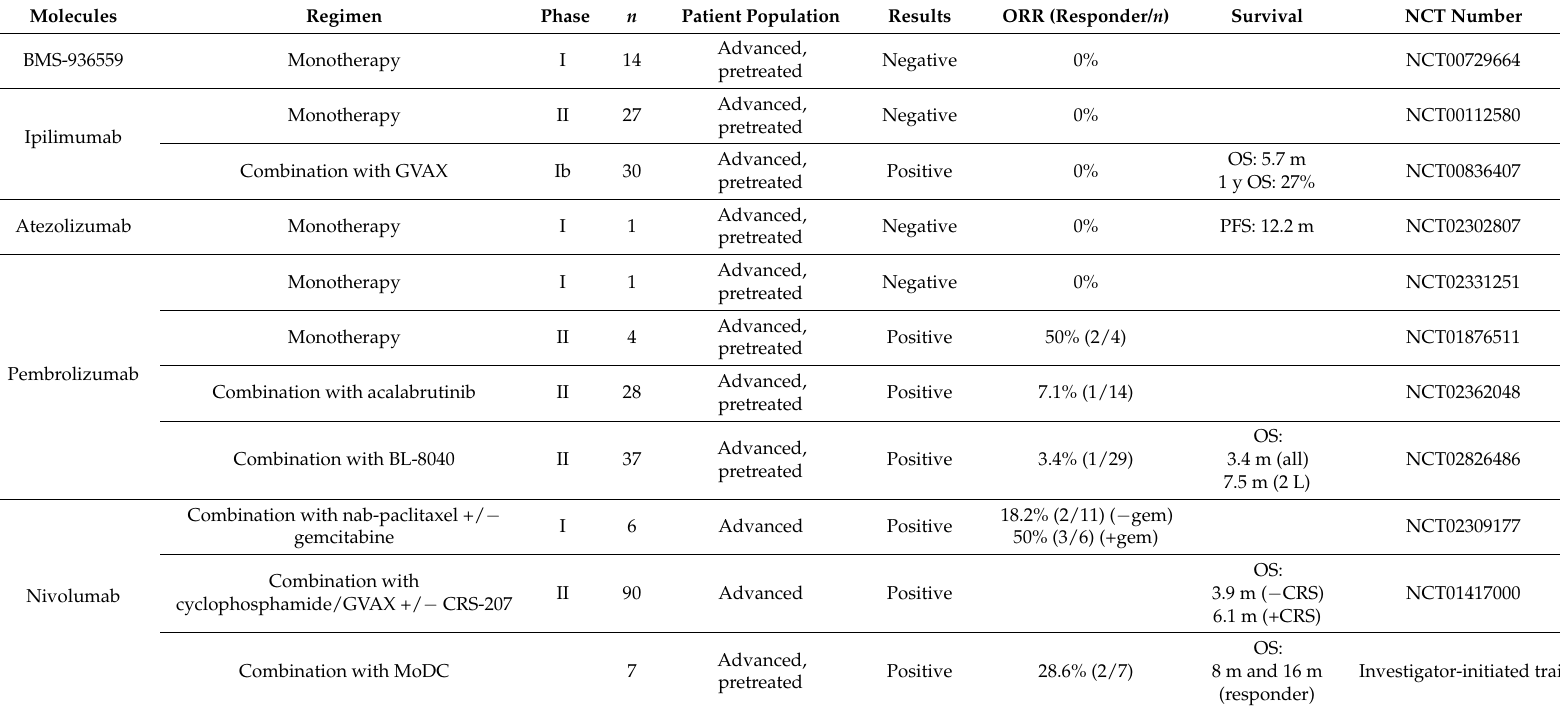
Table 1. Summary of clinical trials on checkpoint inhibitor monotherapies or combination therapy in pancreatic